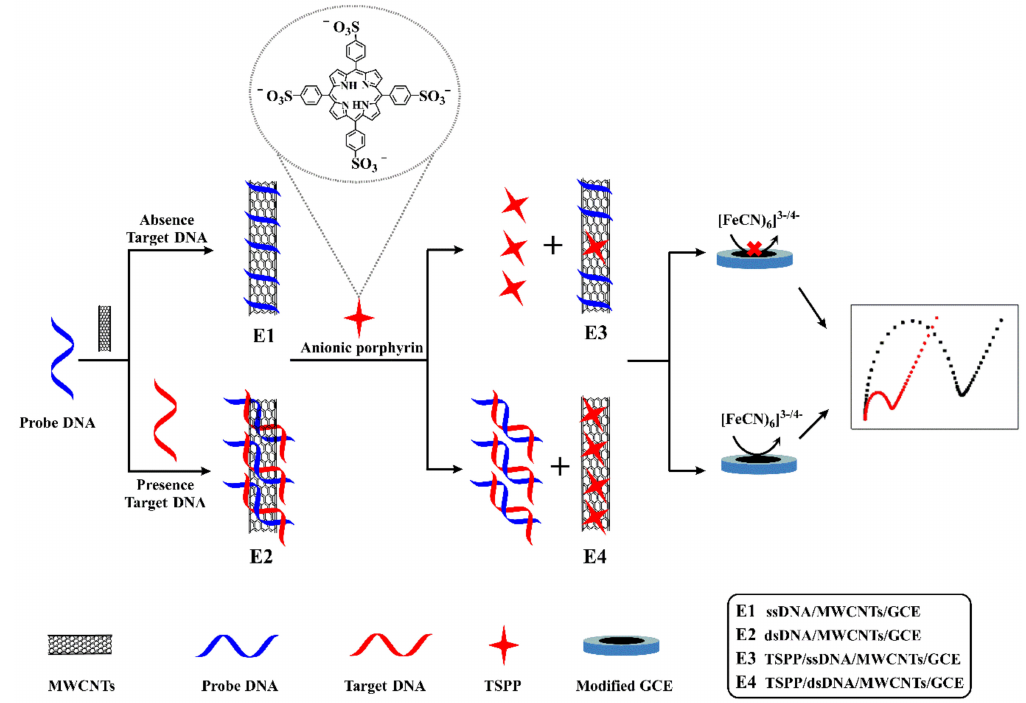
Scheme 1. The strategy for DNA detection through electrochemical impedance spectroscopy based on different interactions between anionic porphyrin and different DNA/CNTs